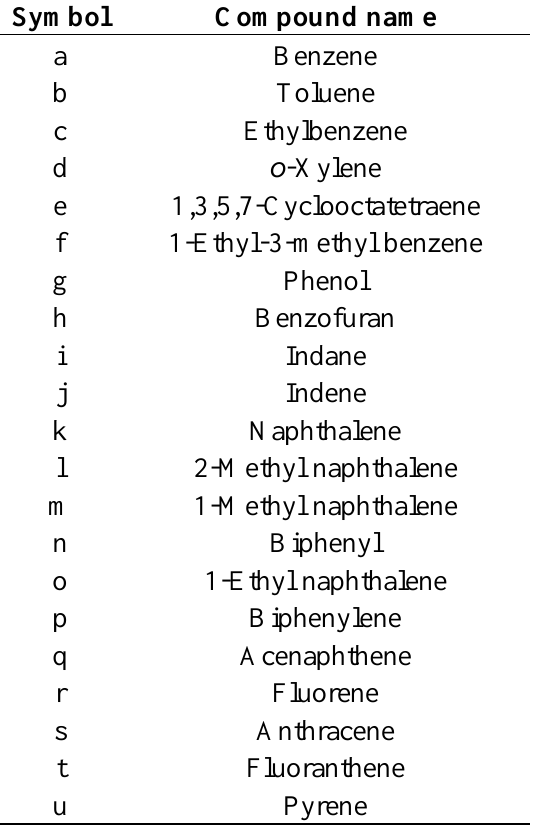
Table 6. Qualitative analysis result of collected